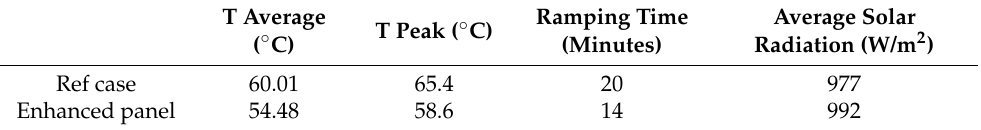
Table 2. Indoor test results.